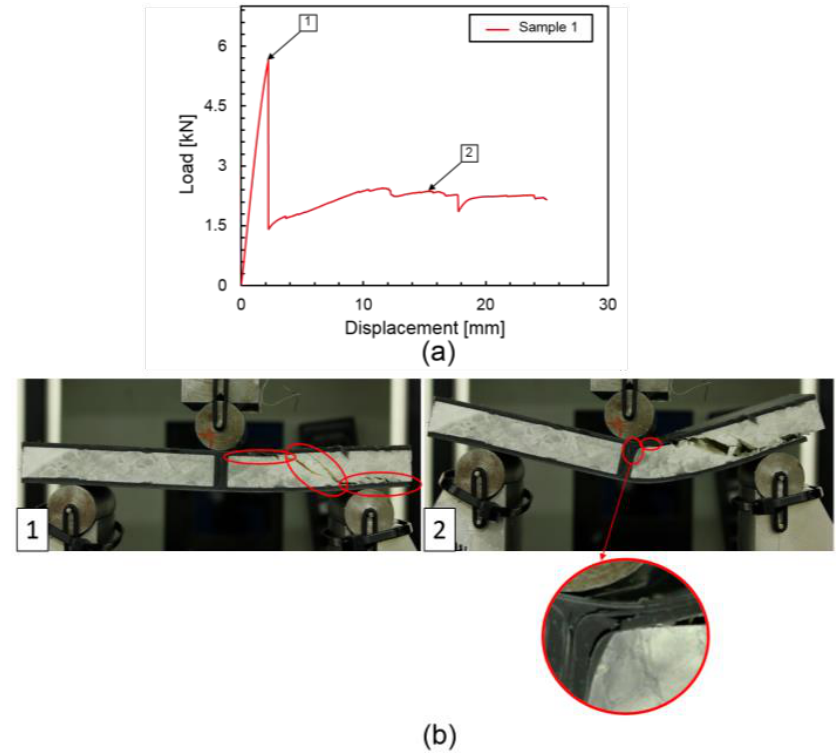
Figure 6. ( a ) Experimental load–displacement curve and ( b ) images of failure development for sample with ‘Configuration 2’. The red ellipses highlight the various types of damage indicated in the